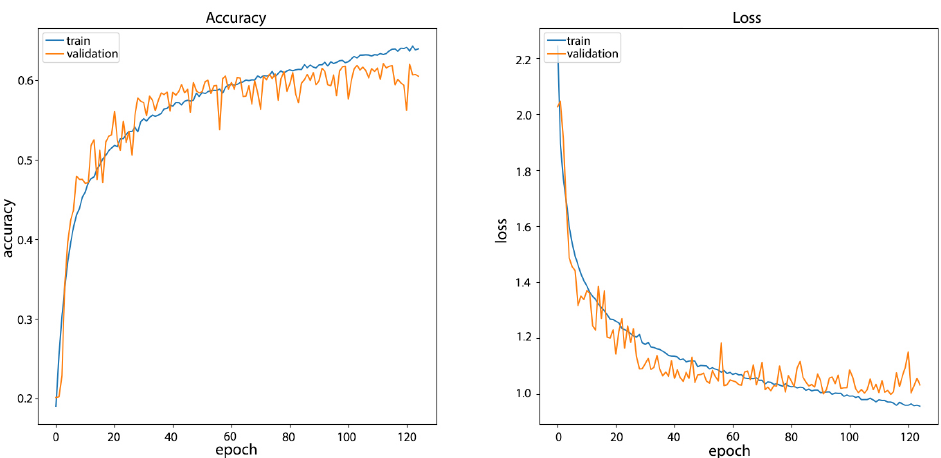
Figure 10. CNN Model_F4 training results on FairFace filtered dataset with plotted landmarks.